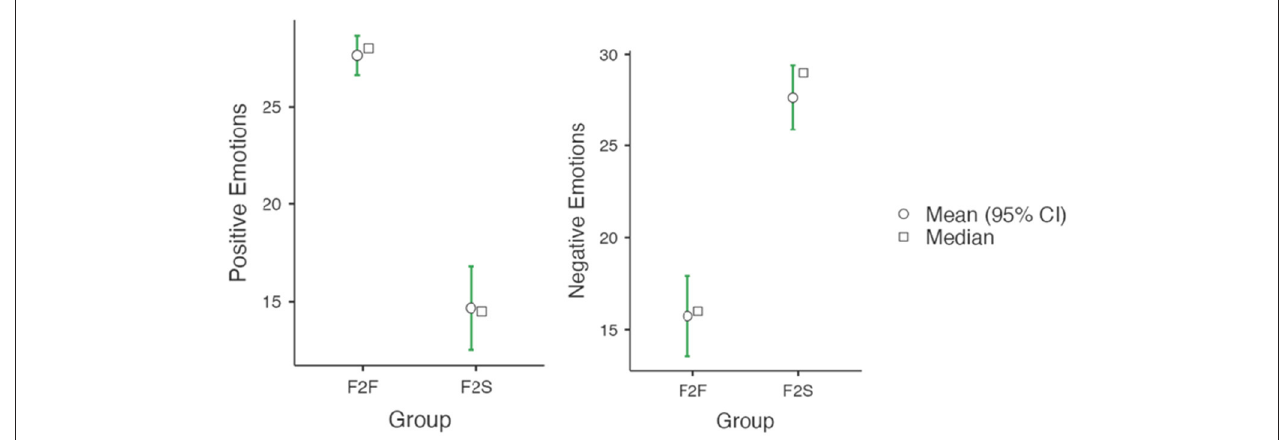
FIGURE 2 | Emotion analysis for F2F and F2S flipped classroom after the course completion.